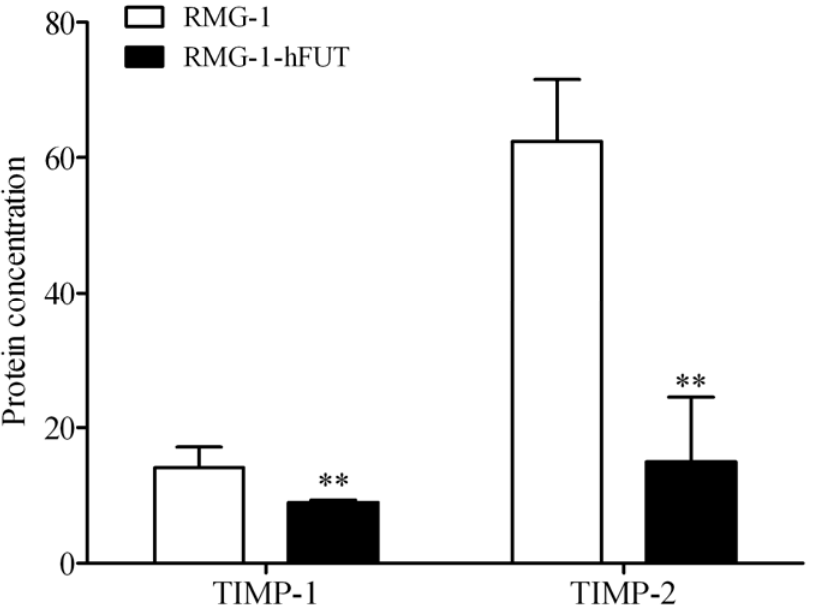
Figure 3. TIMP-1 and TIMP-2 concentrations as measured in the culture supernatants by ELISA. A diminution of TIMP-1 and TIMP-2 secretion was observed in RMG-1-hFUT when compared with RMG-1 cells. ** P <